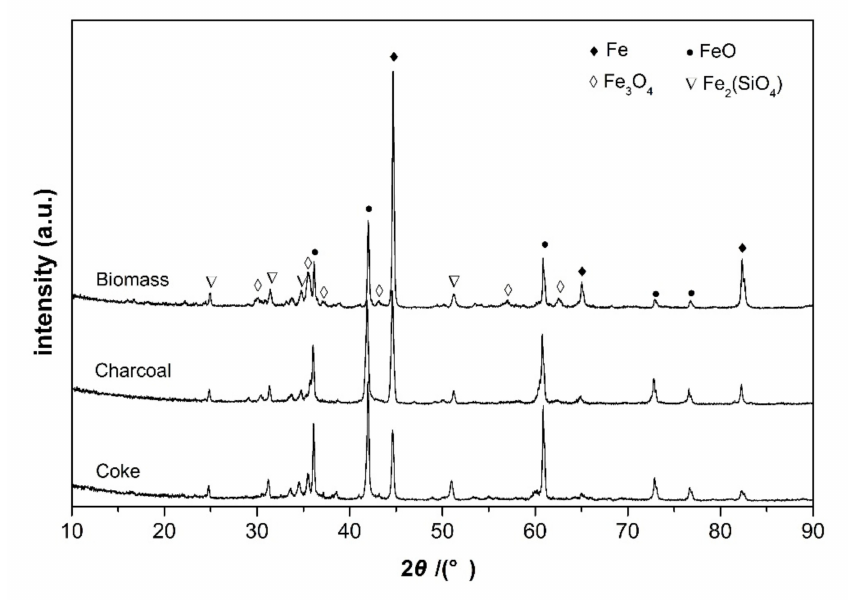
Figure 4. XRD patterns of the three composite pellets with different reducing agents after being reduced at 900 ◦ C for 90